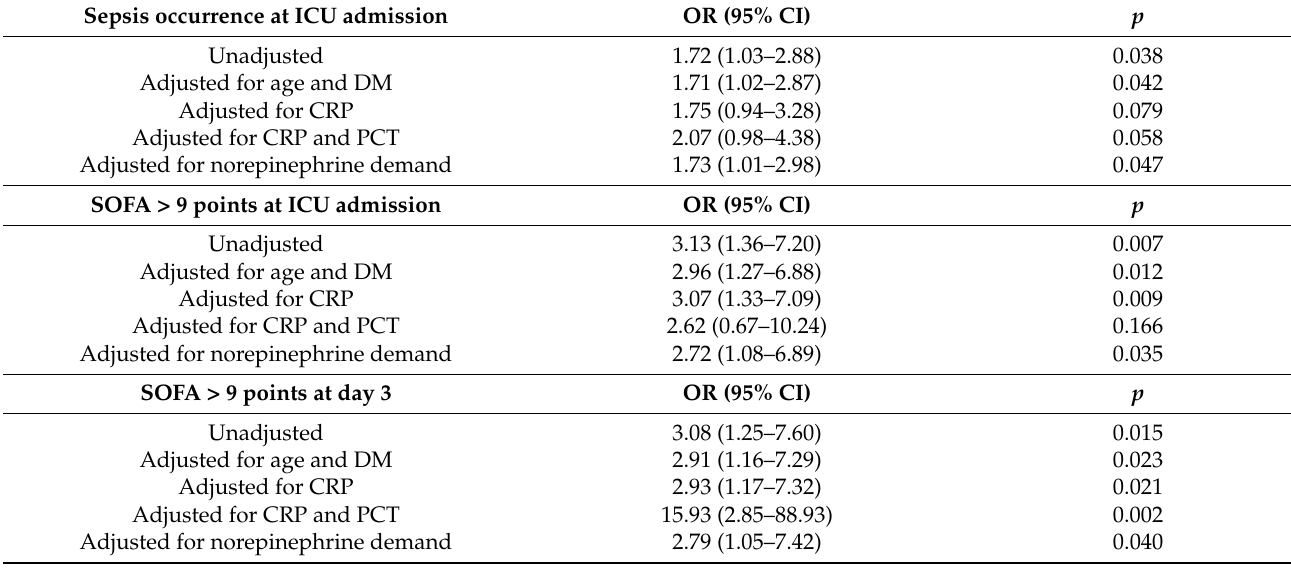
Table 3. Logistic regression analyses for serum PLIN2 concentrations above the median concentration and clinically relevant outcome